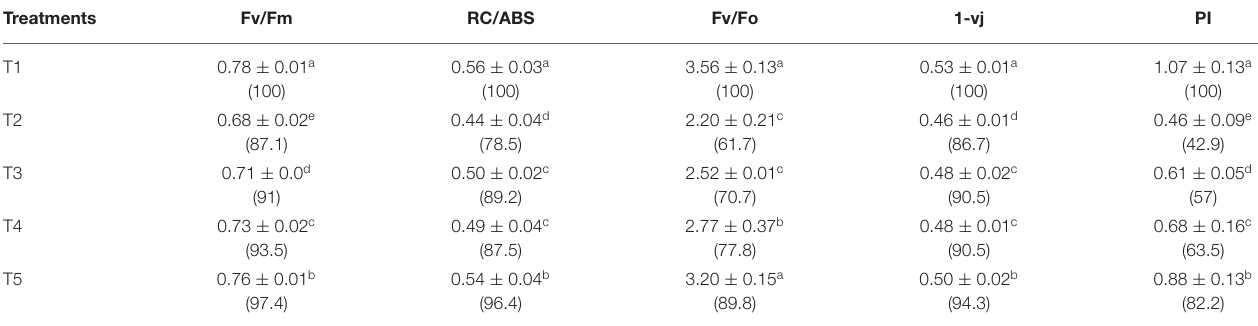
Values are means ± SEM, n = 3 per treatment group. Means in a row without a common superscript letter differ (P < 0.05) as analyzed by one-way ANOVA and the TUKEY HSD test.